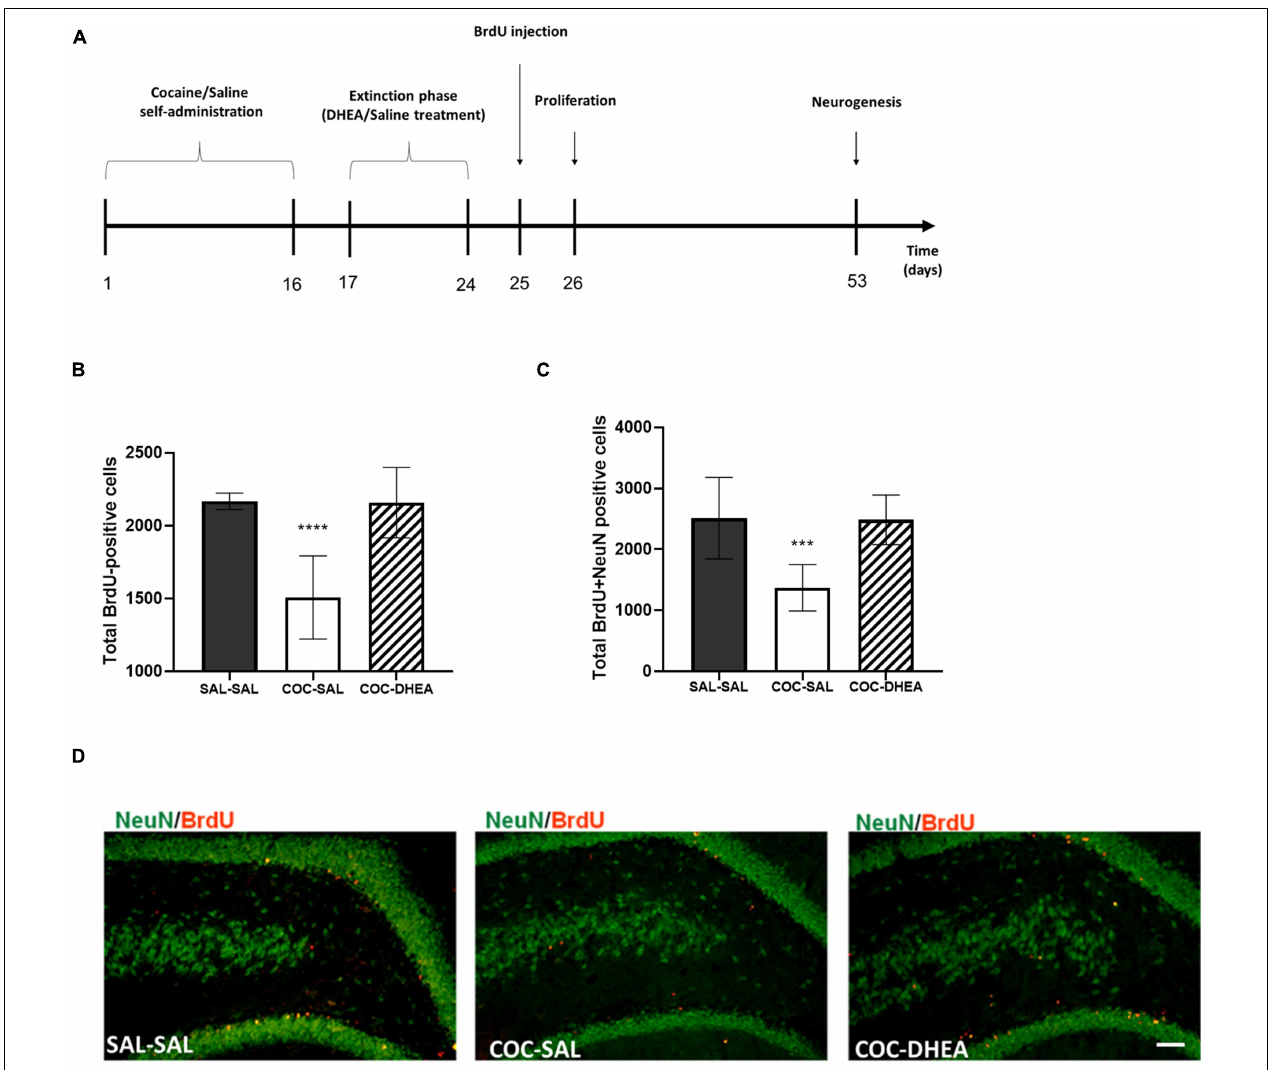
FIGURE 2 | The effect of chronic DHEA treatment on hippocampal proliferation and neurogenesis of cocaine self-administrated rats. (A) Flow chart of proliferation and neurogenesis experiment procedures. 0–16 days: self-administration training of cocaine or saline. 17–24 days: extinction phase and DHEA or Saline treatment. 24 h or 28 days after BrdU injection, brains were excised for proliferation or neurogenesis measurements. (B) Proliferation quantification: BrdU positive cells in the dorsal DG ( n = 7–10). (C) Neurogenesis quantification: newly generated neurons NeuN and BrdU positive ( n = 10 per group). One-way ANOVA of the number of newly formed cells [proliferation; F (2,21) = 23.91, p < 0.0001] and mature neurons [neurogenesis; F (2,27) = 16.82, p < 0.0001] revealed a significant main effect. A post hoc Bonferroni test showed significance between COC-DHEA vs. COC-SAL groups, and SAL-SAL vs. COC-SAL groups (**** p < 0.0001, *** p <